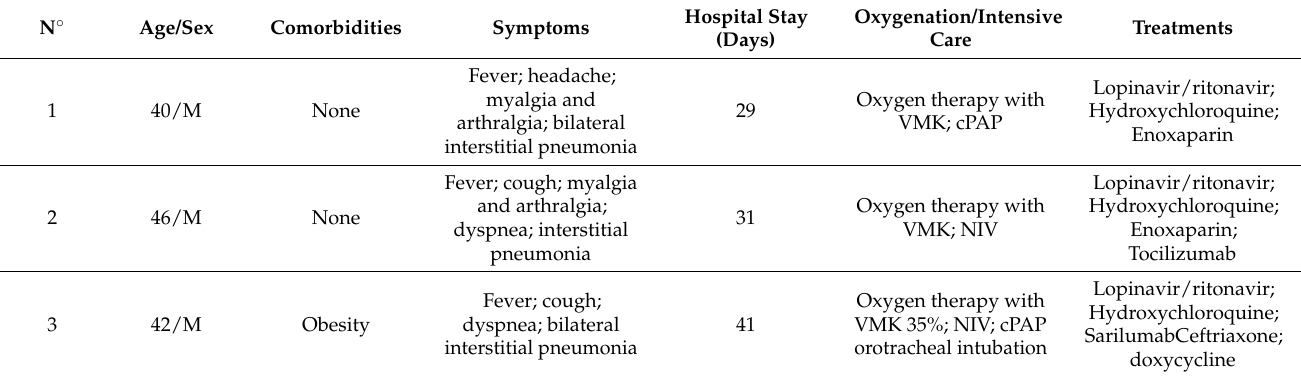
Table 1. Demographics and clinical course of biopsied COVID-19